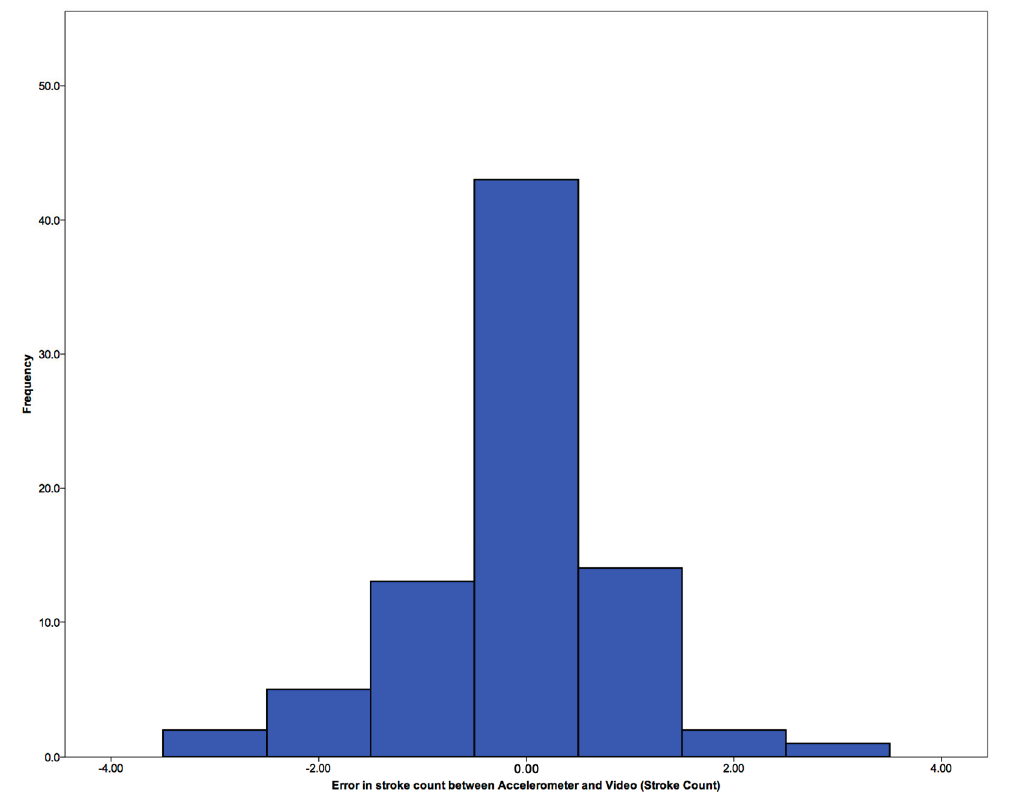
Figure 8. Error in stroke count between video and